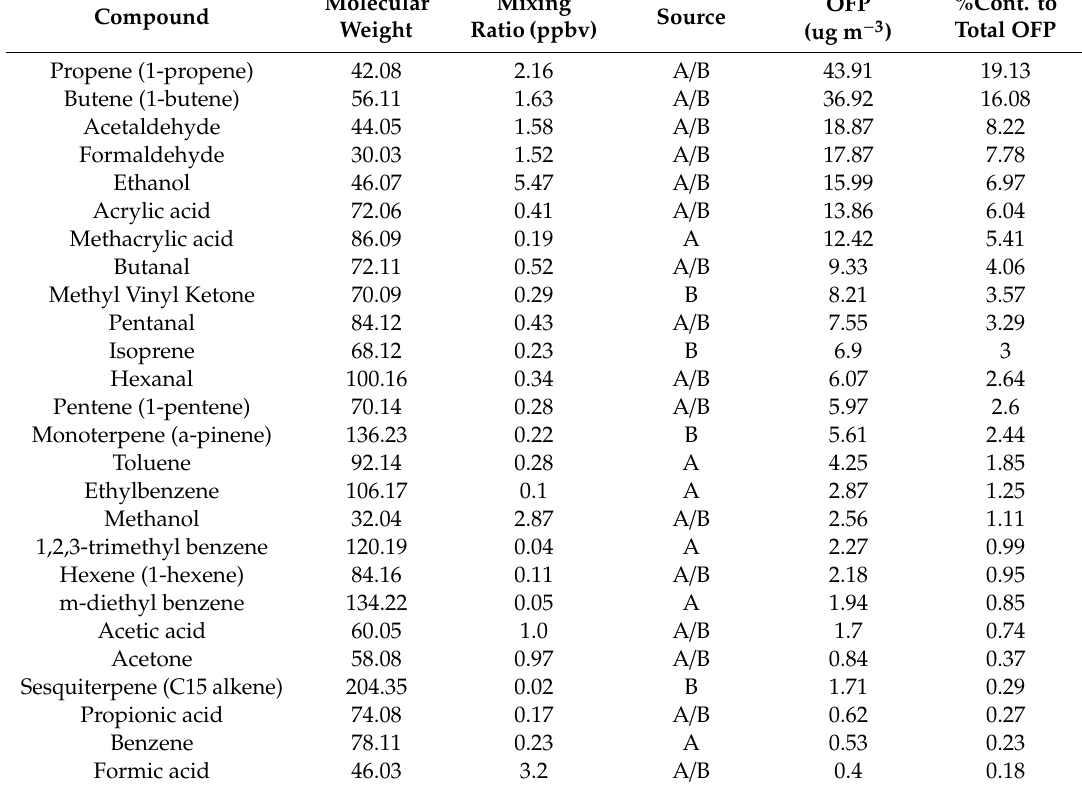
Table 1. The concentration of the most abundant volatile organic compounds (VOC) species and their ozone forming potential (OFP) in Xitou forest. Compounds inside the parenthesis are the basis for the maximum incremental reactivity coe ffi cient (MIR) for compounds with multiple isotopes. Source A: anthropogenic; B: